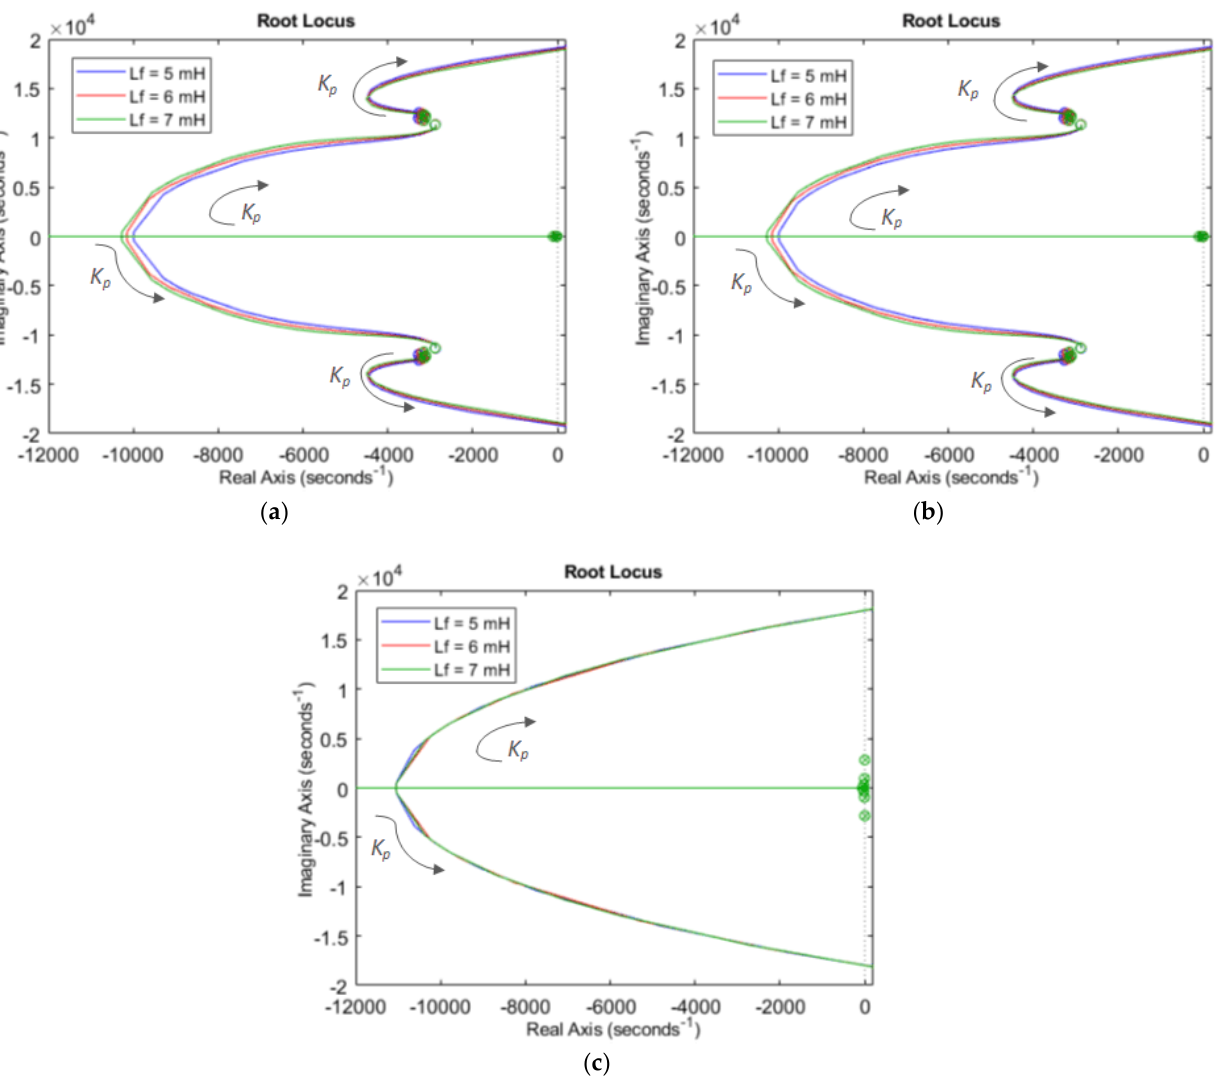
Figure 8. Pole-zero map considering several L f values: ( a ) d -axis, ( b ) q -axis and ( c ) o -axis.